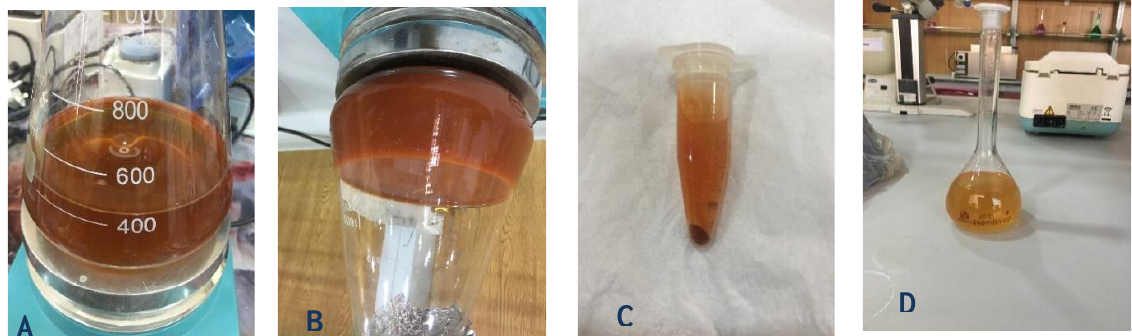
Figure 1. Changing the color after the reduction of sodium selenite to BCSeNPs using black currant extract. A: Image shows black currant aqueous extract, B: Image showed mixture of sodium selenite and black currant extract, C: Image showesBCSeNPs after 48-72 hour, D: Image shows BCSeNPs after